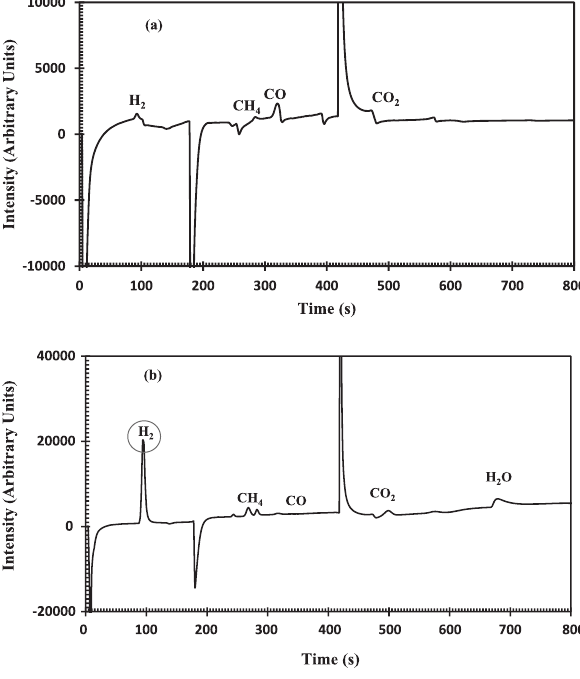
Fig. 9: Gas chromatogram after 60 s of reaction of FeO with (a) coke and (b) PP